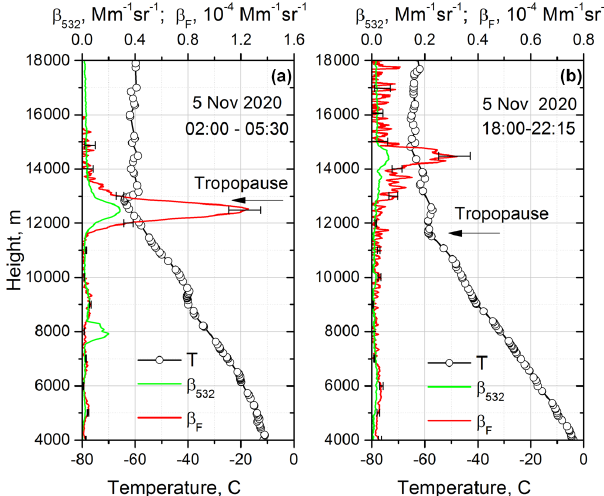
Figure 2. Vertical profiles of aerosol backscattering coefficient β 532 and fluorescence backscattering coefficient β F on 5 Novem- ber 2020 for the periods (a) 02:00–05:30UTC and (b) 18:00– 22:15UTC. Open symbols show the temperature profile measured by the radiosonde launched at Herstmonceux